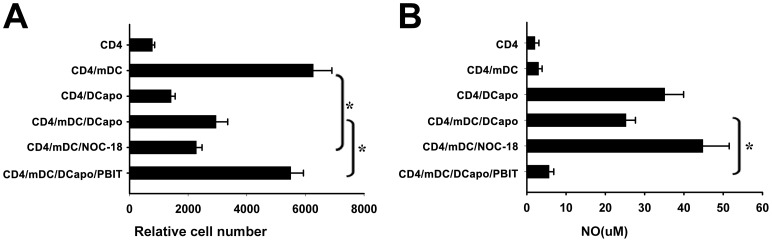
DCapos inhibited CD4+ T cell proliferation via NO.Purified DO11.10 CD4+ T cells (2×105 cells) stained with CFSE were co-cultured with OVA323–339-loaded mDCs (2×104 cells) in the presence or absence of DCapos (2×104 cells) for 4 days in vitro. (A) The NO donor NOC-18 and the NOS inhibitor PBIT were added to the co-culture system to evaluate their effect on the inhibitory function of DCapos. (B) The supernatants of different groups were collected and the NO secretions were tested by Griess assay. *p < 0.05. Data are presented as mean ± SD of triplicate wells, and the results represent 3 separate experiments.